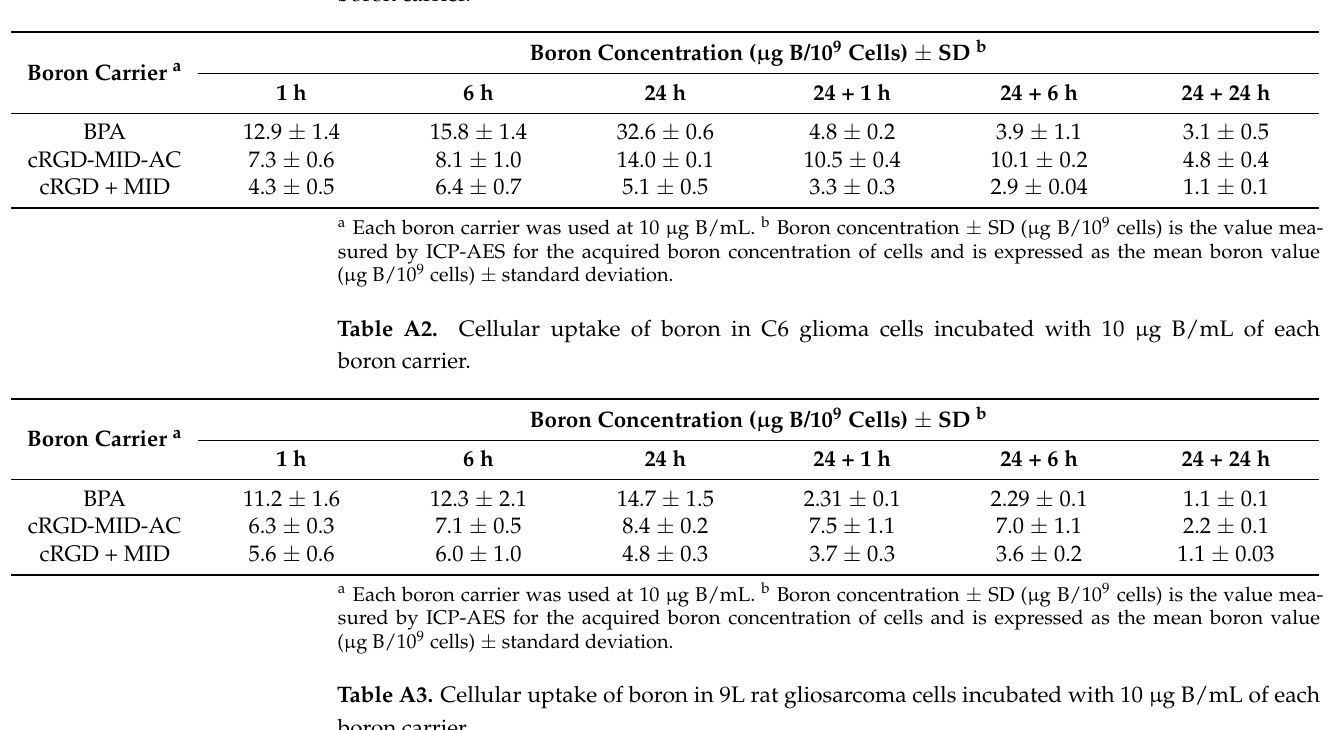
Table A1. Cellular uptake of boron in F98 glioma cells incubated with 10 µ g B/mL of each boron carrier.